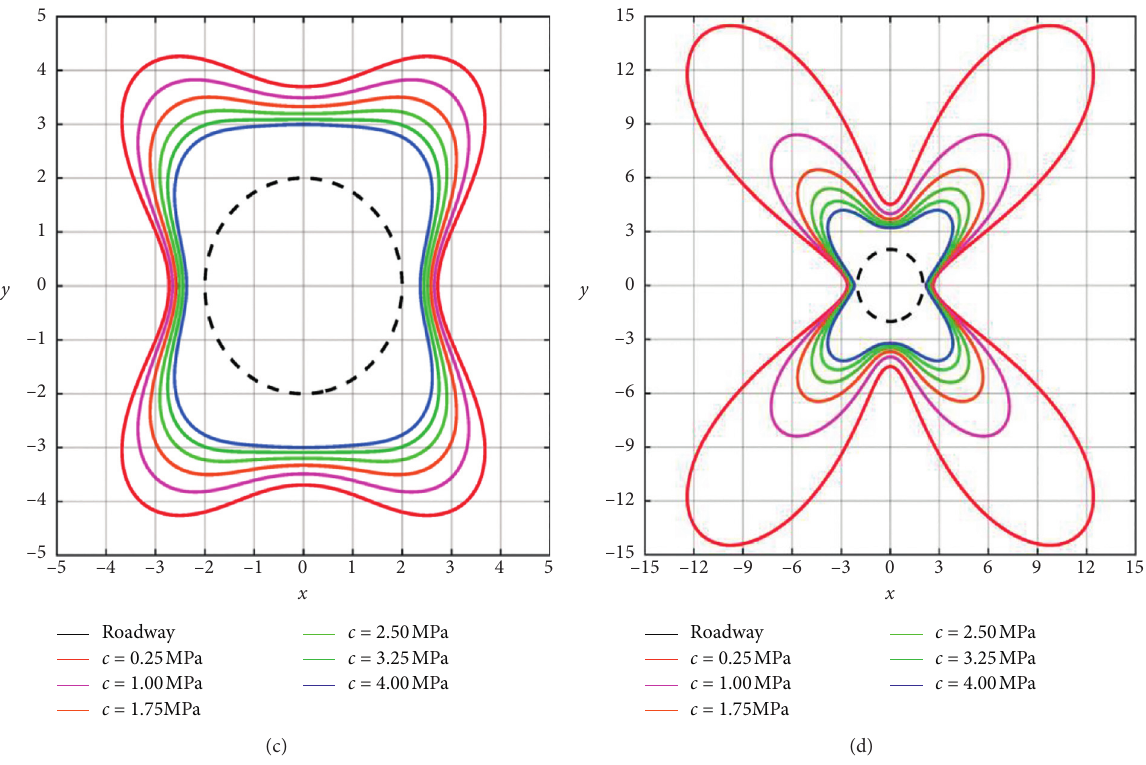
Figure 8: Distribution of plastic zone for various cohesive forces. (a) λ � 1.00. (b) λ � 1.48. (c) λ � 1.96. (d) λ � 2.44.